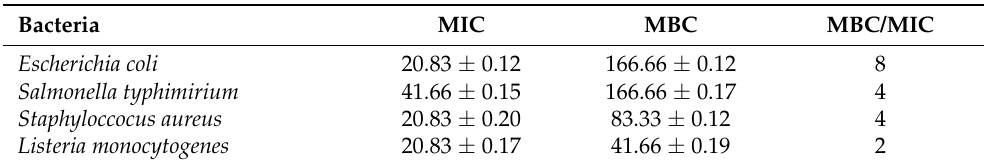
Table 3. Minimum inhibitory and minimum bactericidal concentrations exhibited by the hydroethano- lic extract from Rosa damascena flowers